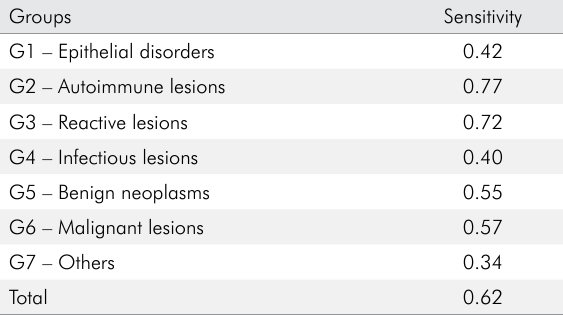
Table 2. Sensitivity test values for clinical examination and diagnosis of lip lesions according to groups of histopathological diagnoses.